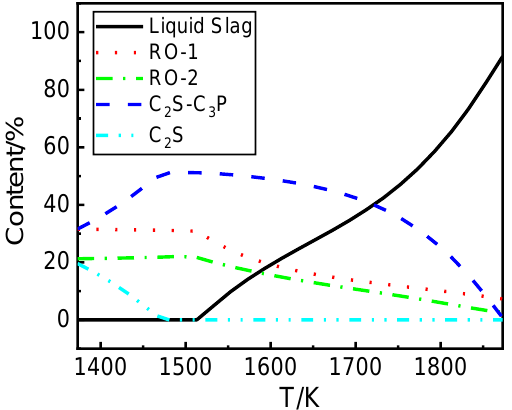
Figure 1. Equilibrium solidification curve of decarburization